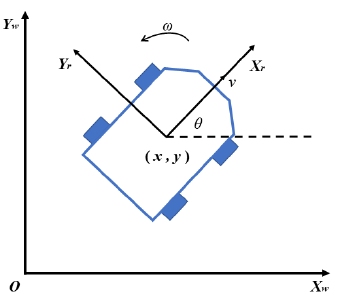
Figure 5. The coordinate system of a mobile